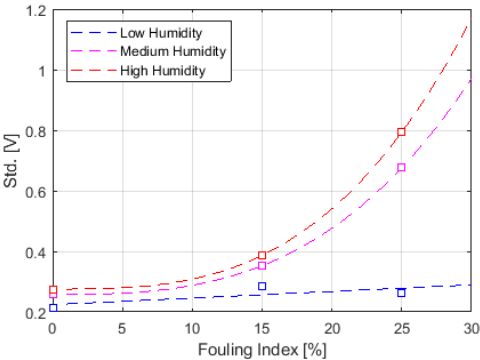
Figure 11. Standard deviation of the surface reflection amplitude against fouling and moisture conditions.